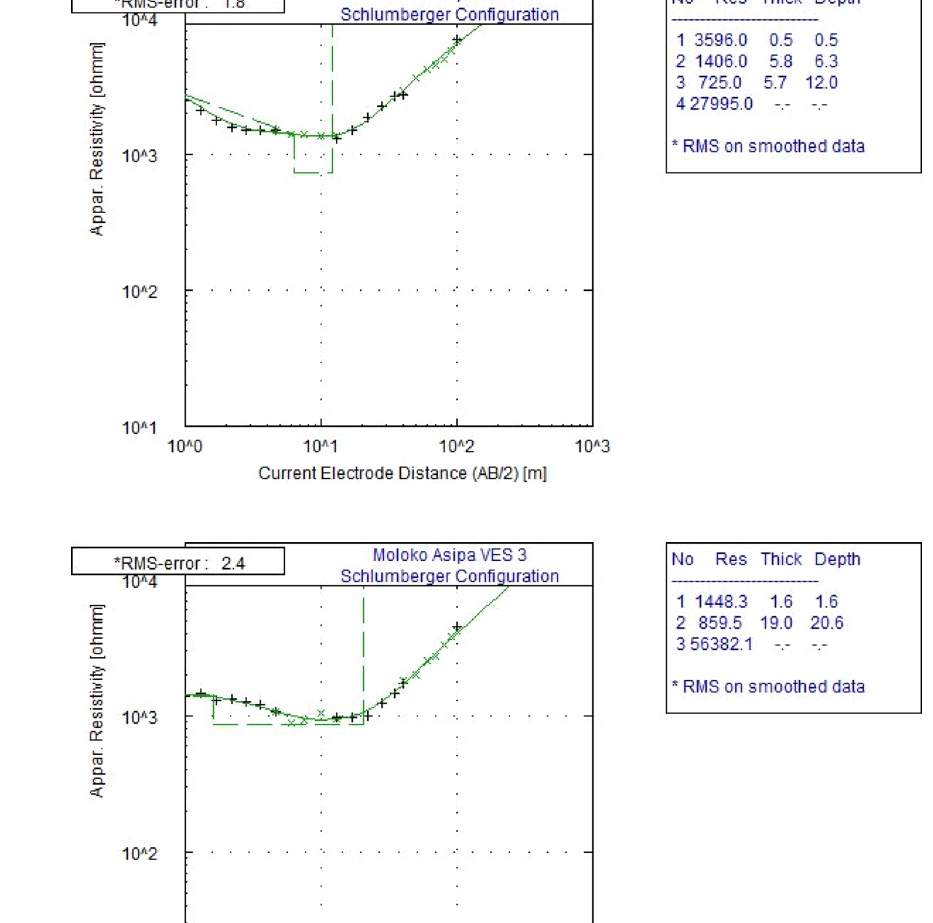
Fig. 11 Layer model interpreta- tion for VES 1